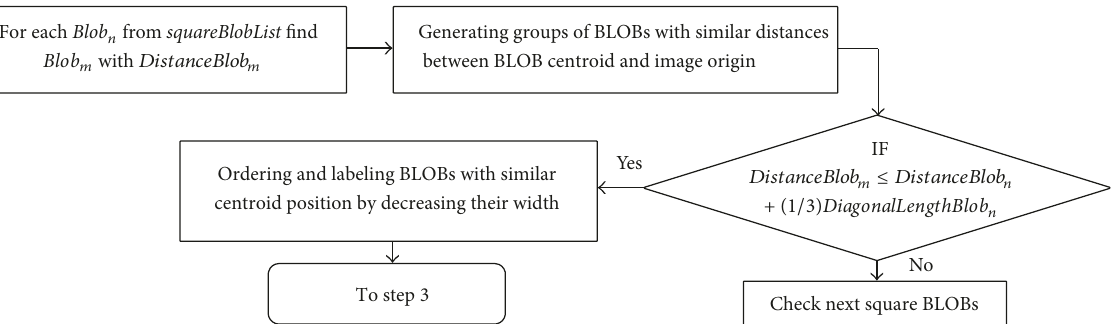
Figure 4: Step 2 : block diagram of algorithm for searching and grouping square BLOBs with similar positions of their centroids.